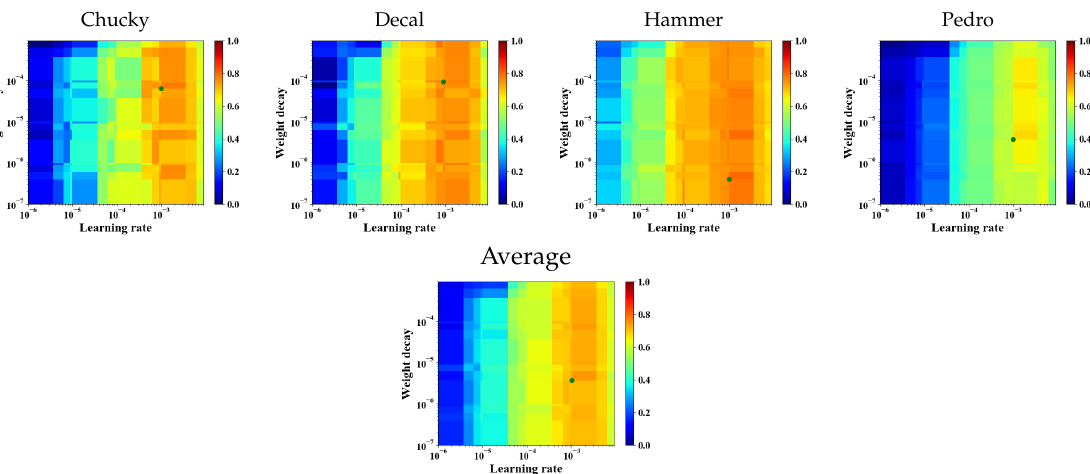
Figure 5. Vision: Performance in terms of ALC of MobileNetV2 as a function of weight decay and learning rate, shown for the four image datasets ( top row ) as well as averaged over all datasets ( bottom row ). The best performance is indicated by the green dot.